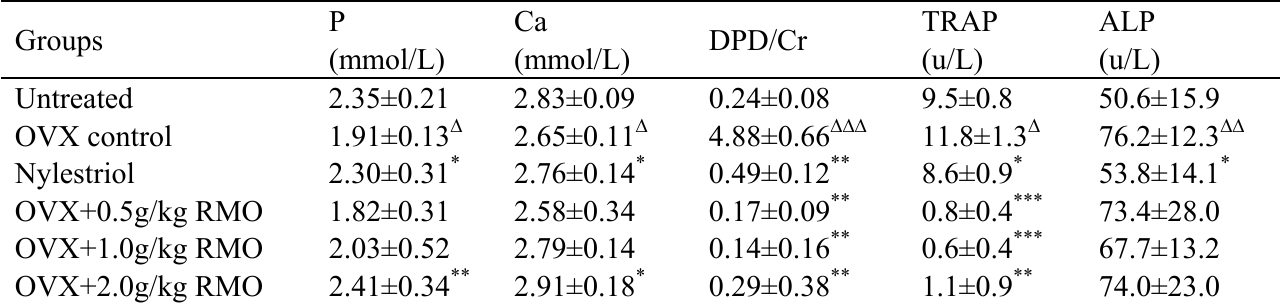
Table 4. Effects of RMO on serum P, Ca, DPD/Cr, TRAP and ALP levels in OVX rats (n=10).